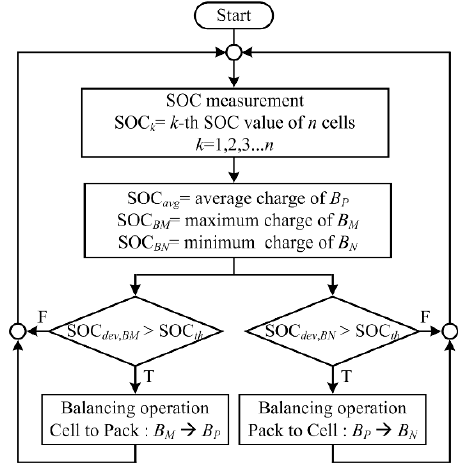
Figure 5. ( a ) Equivalent circuit of the Li-ion battery cell and ( b ) OCV(state of charge (SOC)): OCV versus SOC characteristic of the experimental Li-ion cell.